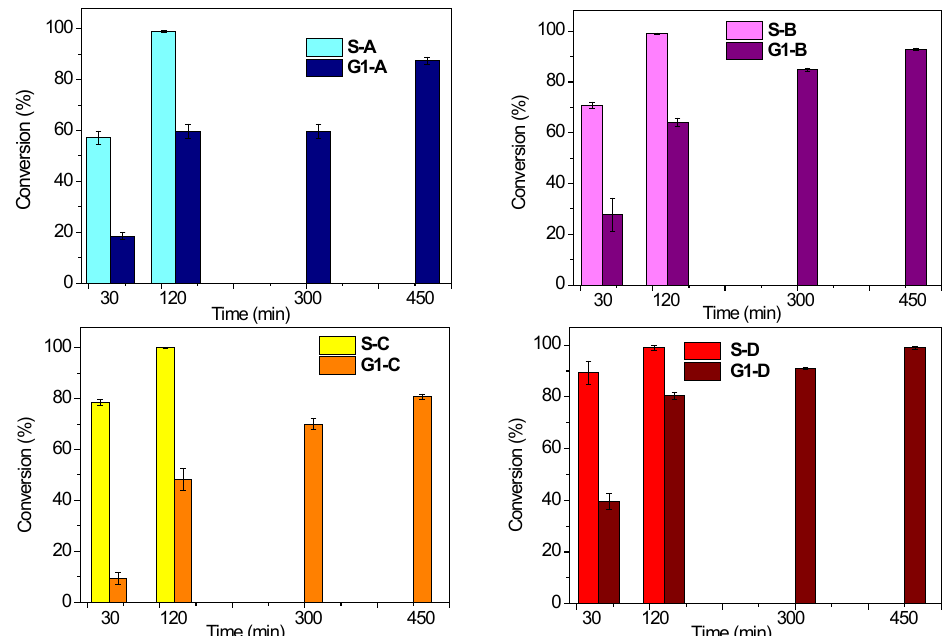
Figure 8. Kinetic of the lactonization of profragrances A – D in solution ( S ) and in gel ( G1 ) using solar light- Top left: profragrance A; top right: profragrance B; bottom left: profragrance C; bottom right: profragrance D. The experiments were repeated in triplicate and results are expressed as mean ± standard deviation.